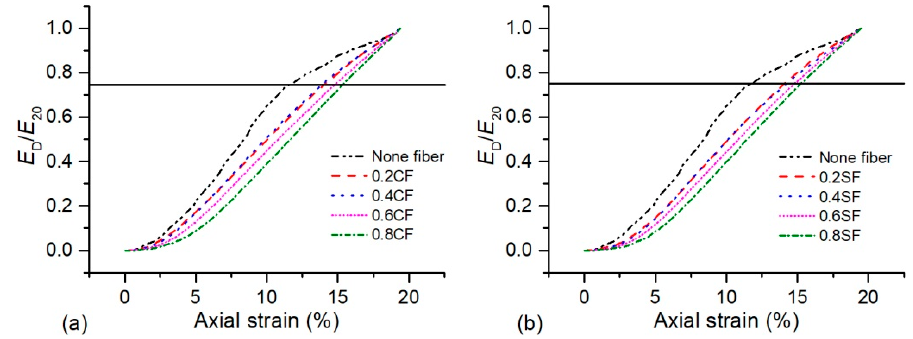
Figure 10. The normalized absorption energy curve of the polymer-treated sand with ( a ) CF and ( b ) SF.